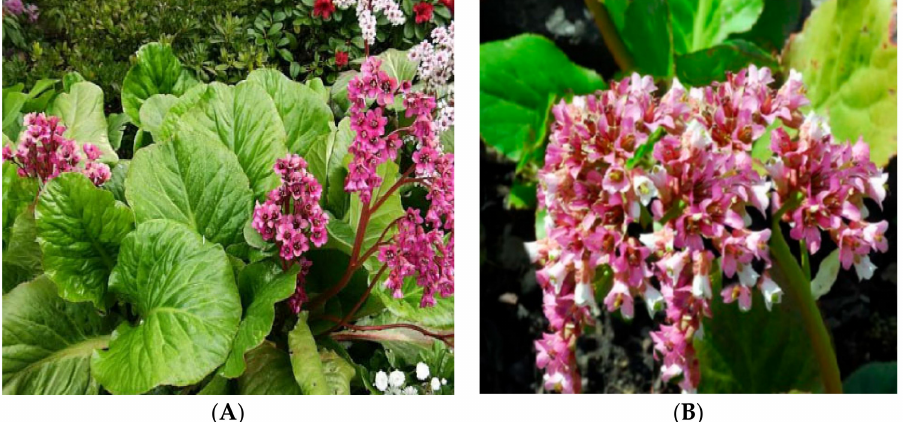
Figure 1. Bergenia pacumbis (Buch.-Ham. ex D.Don) C.Y.Wu & J.T.Pan ( A ) Whole Plant ( B ) Flower [3,13].